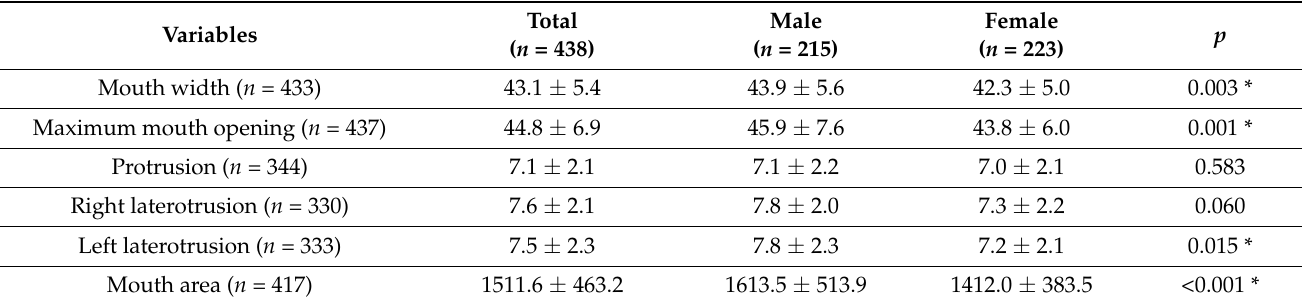
Table 1. Baseline participant data using a two sample t -test.